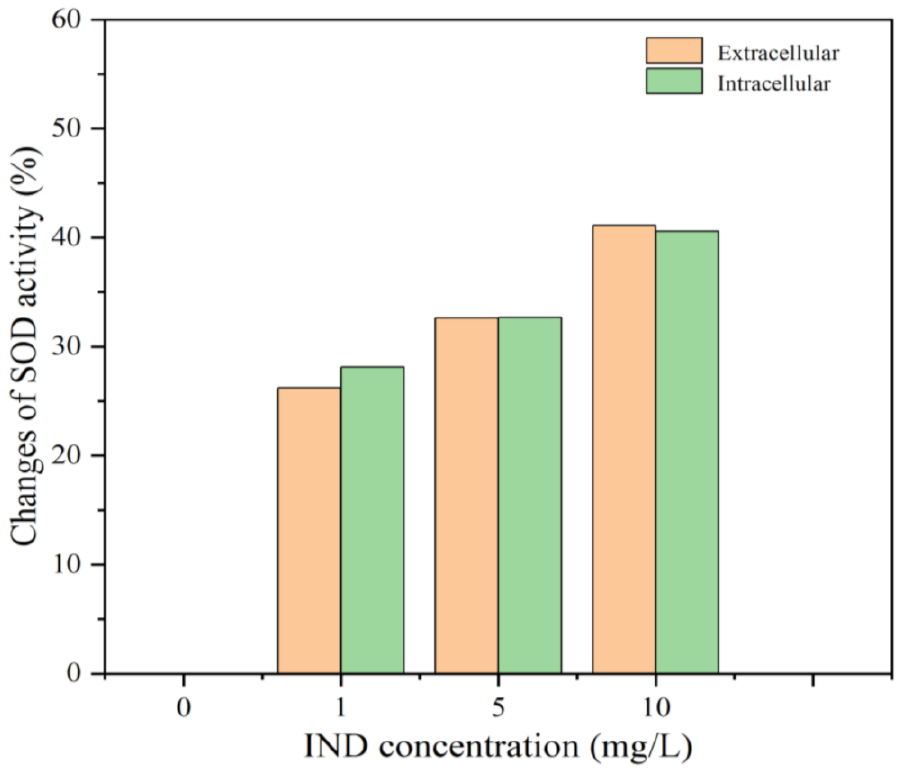
Figure 3. Contrast diagram of changes in SOD activity between intracellular and extracellular. Experimental Conditions: T = 298 K, pH = 7.4, c (SOD) = 1 µ M, c (IND) = 0, 1, 5, 10